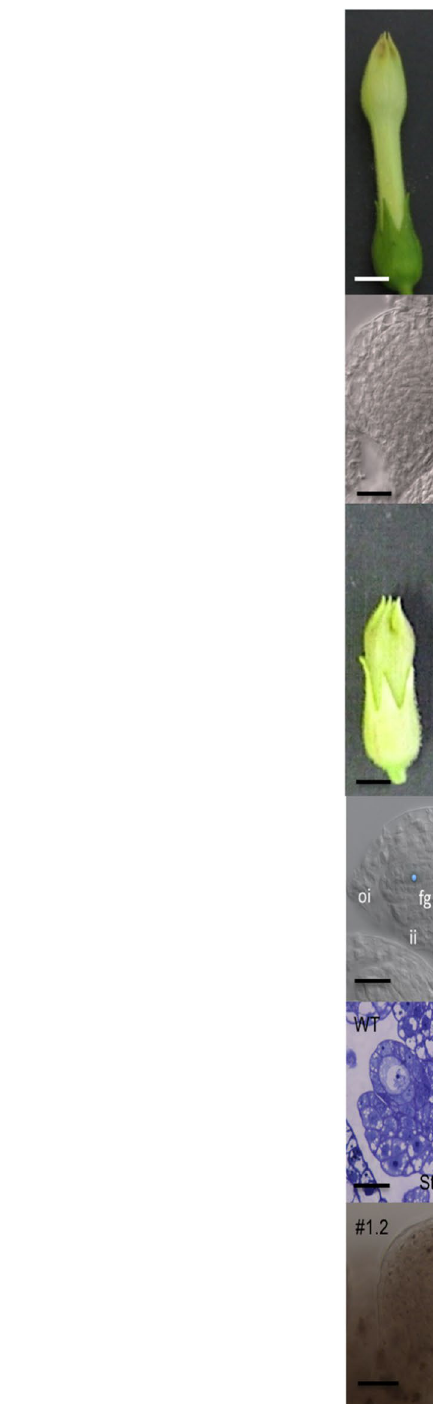
FIGURE 6 | Detailed type I MYB10.1 phenotype during flower development. (A) Alteration of floral development in type I compared to (C) WT (stages were defined according to Koltunow et al. (1990). Bars = 200 pixel. (B) Cleared sections in wild-type developing ovules from stage st3-I to st3-V, the seven-celled embryo sac. (E) In ovules of overexpressing lines, the development is blocked to st3-I. (D) Thin sections of WT and type I ovules confirm the developmental arrest. (F) Aniline blue staining evidenced the persisting deposition of callose in pollinated type I plants, while the callose disappears in pollinated wild-type flowers. Ovules stages are according to Schneitz et al. (1995). ap, antipodal cells; cc, central cell; ec, egg cell; fg, FG; ii, inner integument; oi, outer integument; syn, synergid cells; v, vacuole. Bars are 1 cm in A and B; 50 µm in B, D, E, F St3-I; 200 µm in F